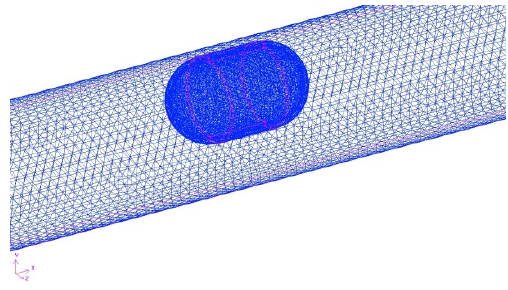
Figure 4. Grid diagram of the robot system ( d = 18